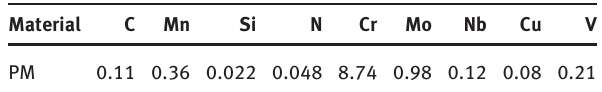
Table 2: Chemical compositions for grade P91 steel